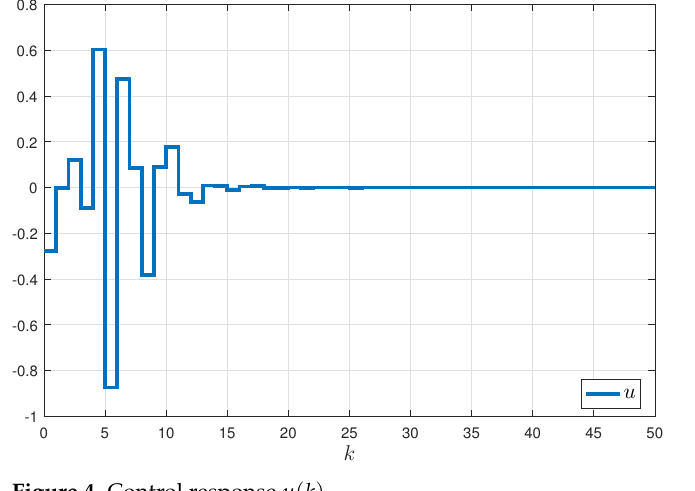
Figure 4. Control response u ( k ) .